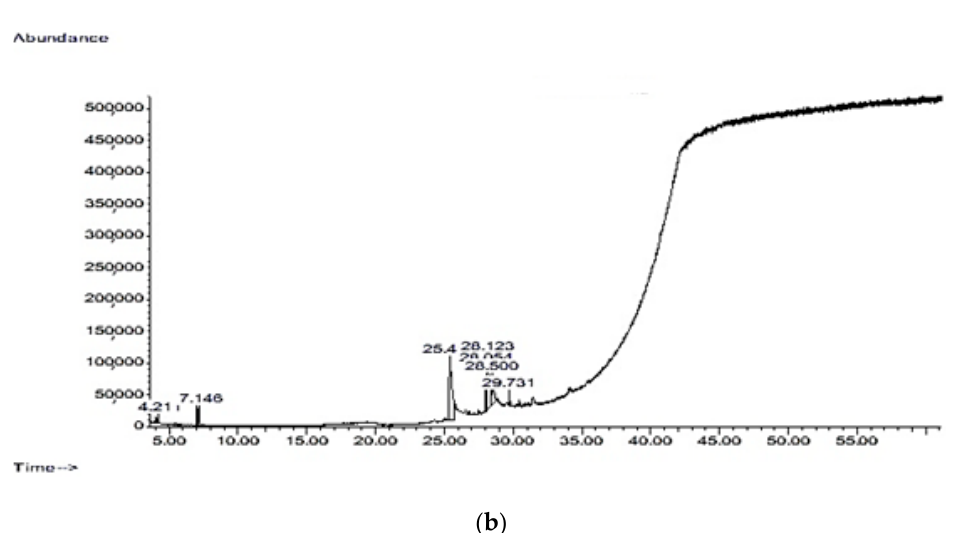
Figure 1. ( a ) HPLC chromatogram of the standard mixture of flavonoids and phenols of Rumex nervosus at 280 nm; ( b ) Gas chromatography-mass spectrometry (GC-MS) tracing of Rumex nervosus leaf extract. Table 4. Main compounds (%) detected by gas chromatography-mass spectrometry (GC-MS) in the methanolic extract of Rumex nervosus leaf. Retention Time